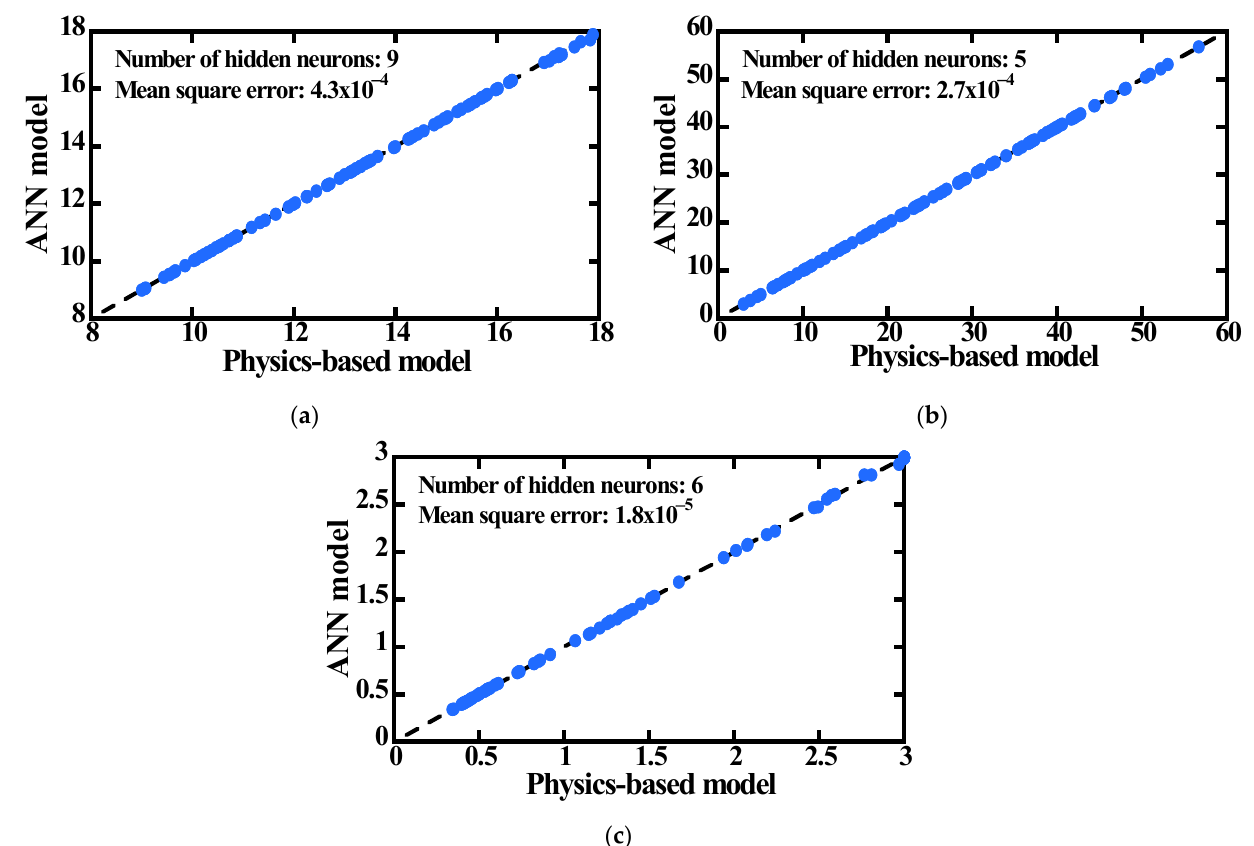
Figure 14. Performance results of the ANN model compared to physics-based model: ( a ) Gas turbine combined cycle; ( b ) Photovoltaic module; ( c ) Wind turbine.